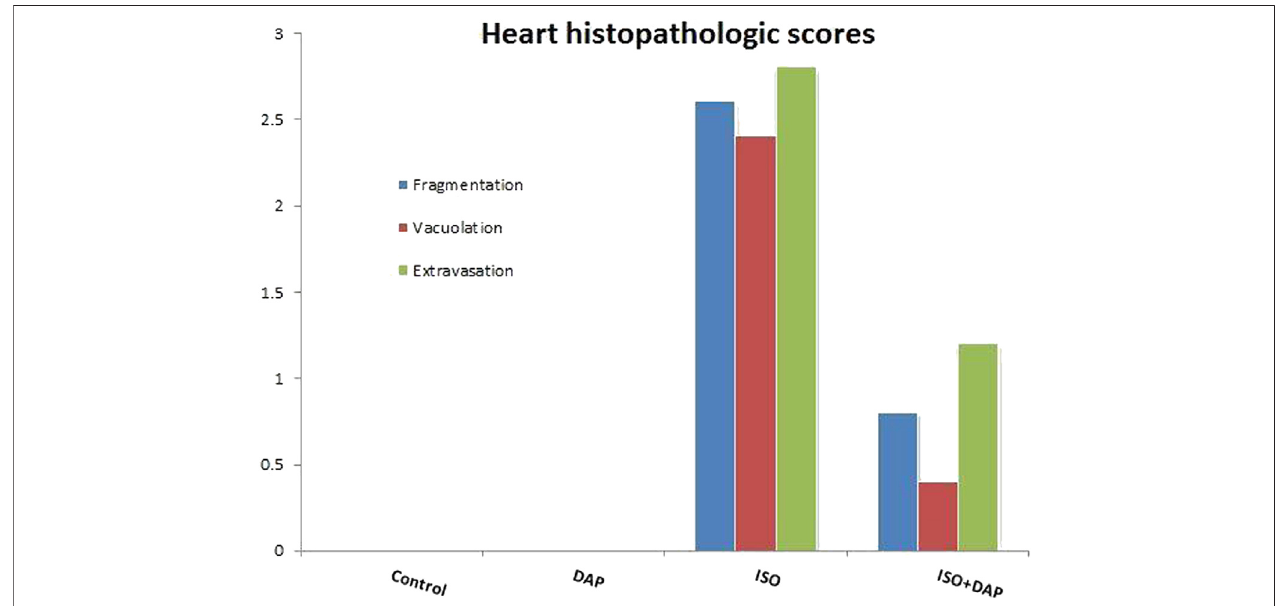
FIGURE 6 | Heart histopathologic